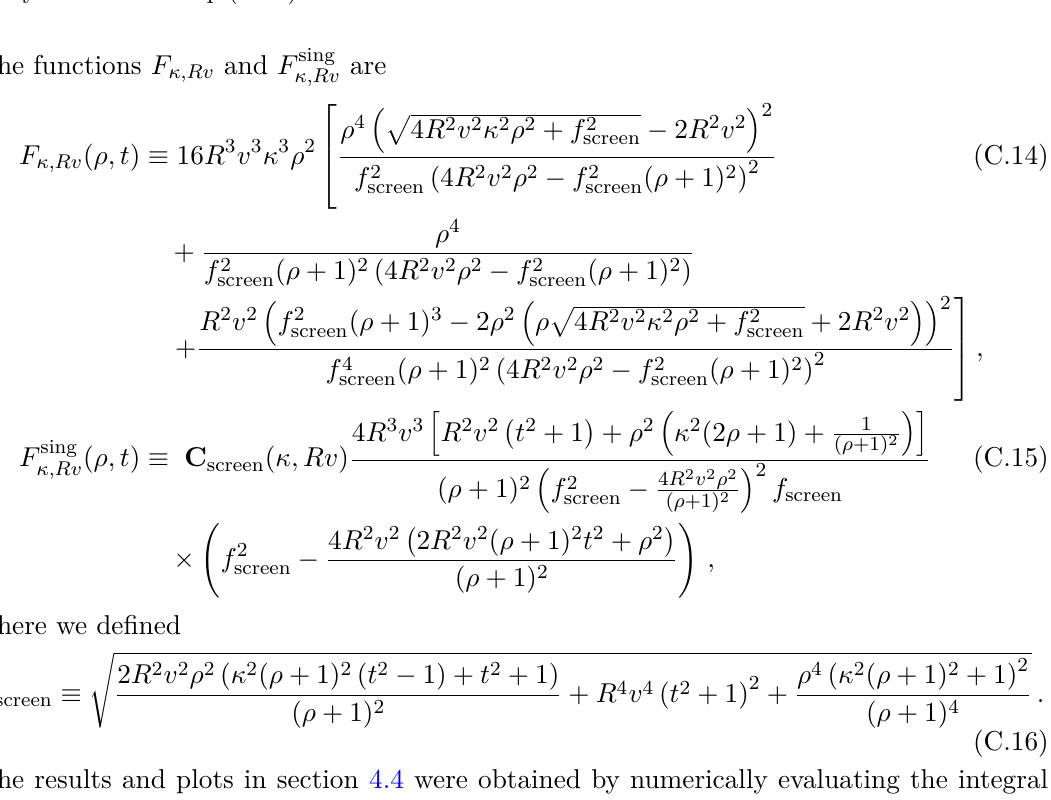
Figure 12 . Left: plot of the embedding eq. (4.44) at Rv = 3 and κ = 1 . The two curves (red and black) correspond to two different values of τ . The embedding reaches the horizon ζ = 1 at two different values, u 1 and u 2 . Right: behaviour of the integral S 1 of eq. (C.21) near ( Rv ) crit at κ = 0 . 5 . The blue dots correspond to the numerical integration while the red curve represents the analytical function eq.